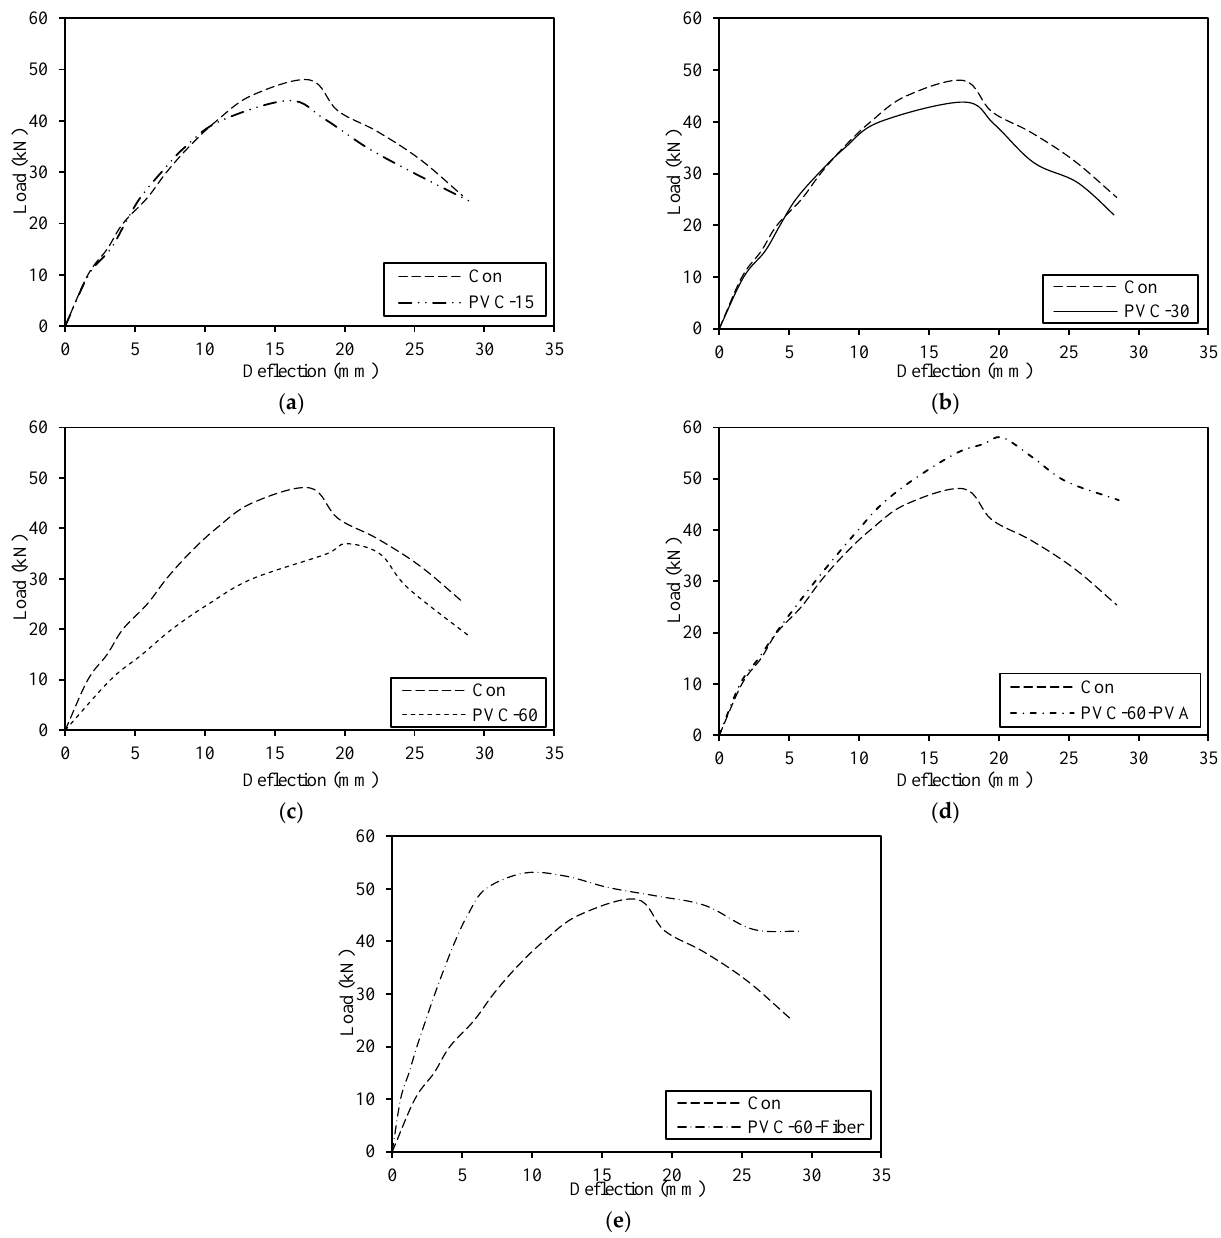
Figure 8. Load-deflection curve of Con specimen with ( a ) PVC-15, ( b ) PVC-30, ( c ) PVC-60, ( d ) PVC-60-PVA, and ( e ) PVC-60-Fiber specimens.